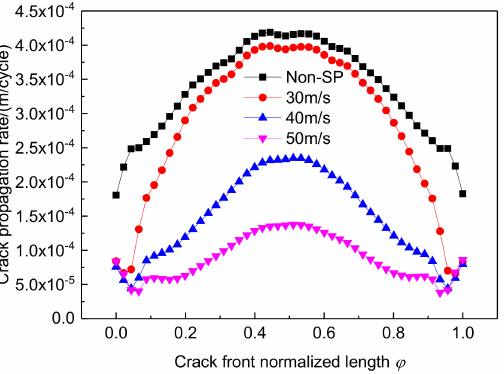
Figure 10. Crack propagation rate after shot peening at different shot